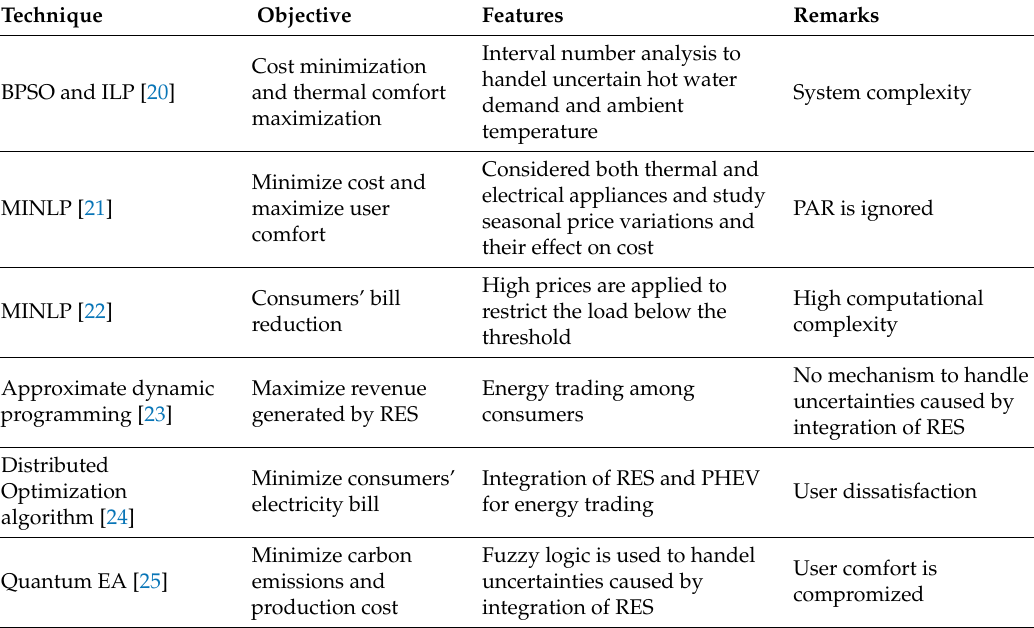
Table 1. Strength and limitations of state-of-the-art